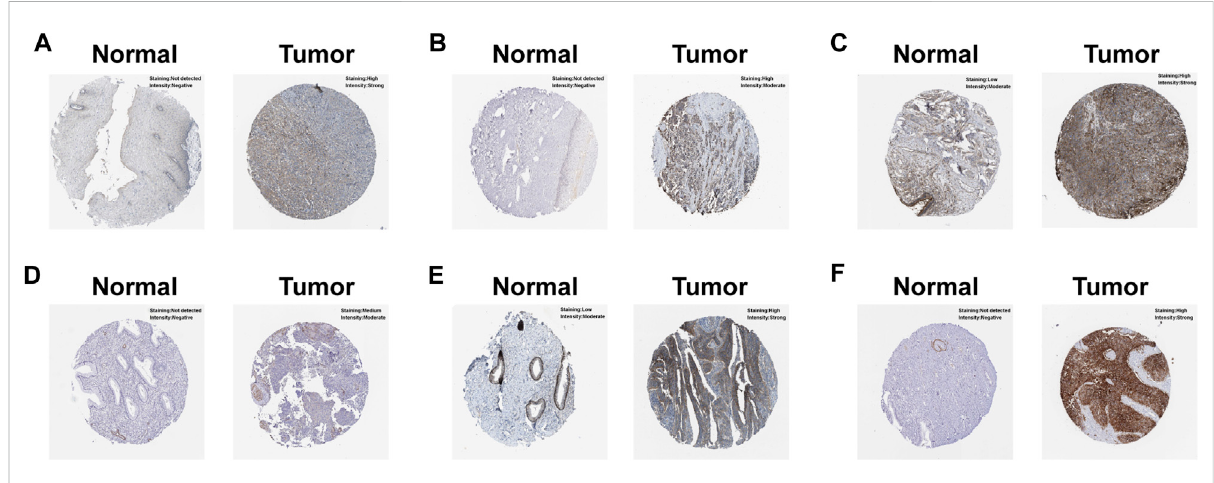
FIGURE 5 Veri fi cation of the hub model genes at protein level by HPA database. (A) EPHB4. (B) LBP. (C) NT5E. (D) PPFIA4. (E) PTGFRN. (F)